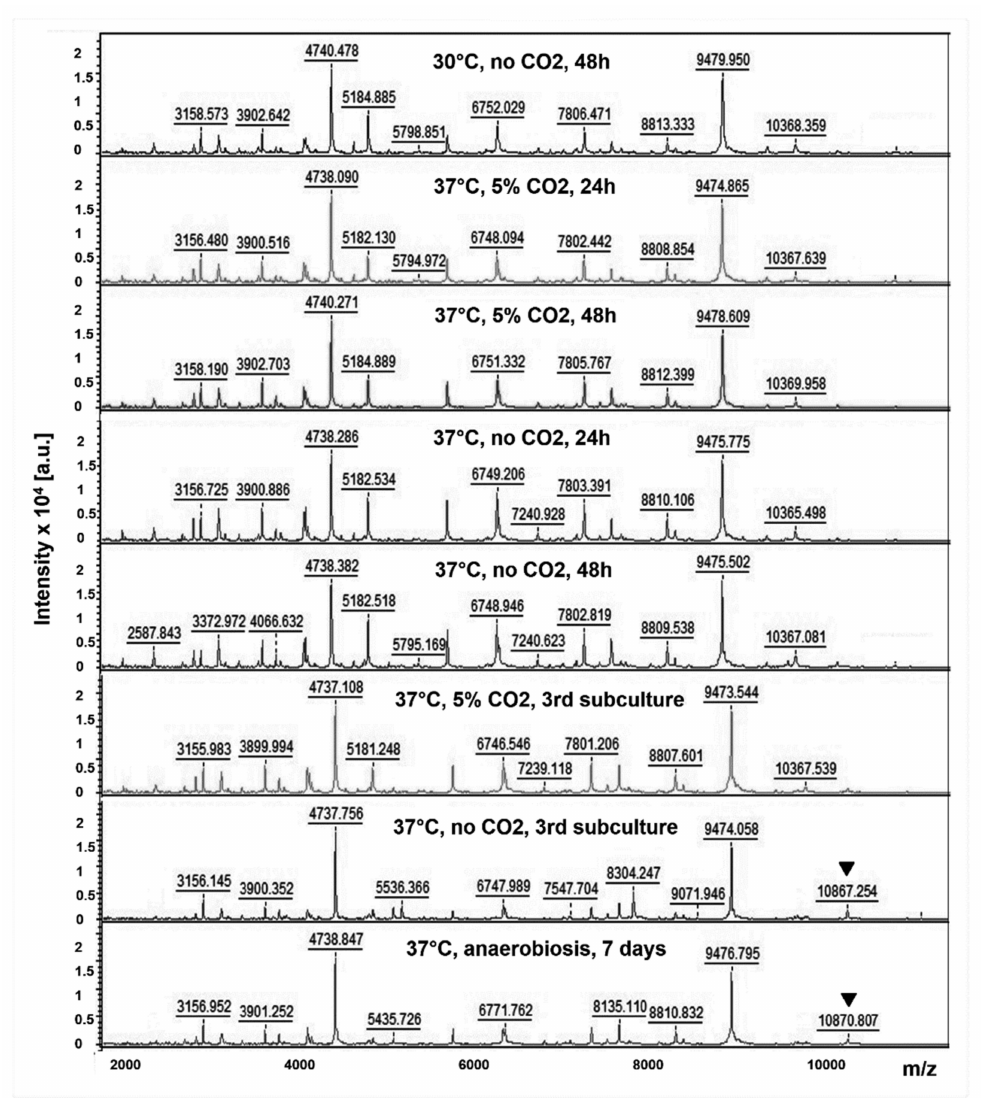
Figure 1. MALDI TOF mass spectra obtained with the LVS strain of F. tularensis subsp. holarctica , at di ff erent culture conditions: 30 ◦ C or 37 ◦ C, with or without 5% CO2, with an incubation time of 24 h or 48 h, and after one subculture (unspecified) or three subcultures. A mass peak in the range 10,360–10,370 Da was missing and replaced by a new peak in the range 10,860–10,870 Da (arrows) when the LVS strain was grown in the anaerobic atmosphere for ten days or after three or more subcultures at 37 ◦ C, without